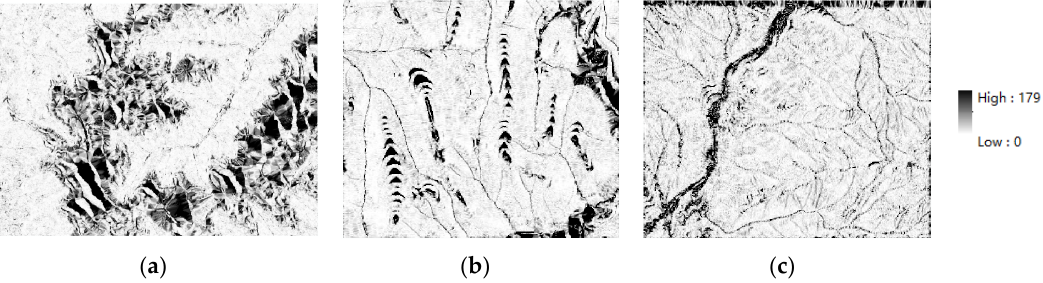
Figure 12. Spatial distributions of aspect errors (( a – c ) respectively represent the spatial distributions of aspect errors of study area 1, study area 2, and study area 3).